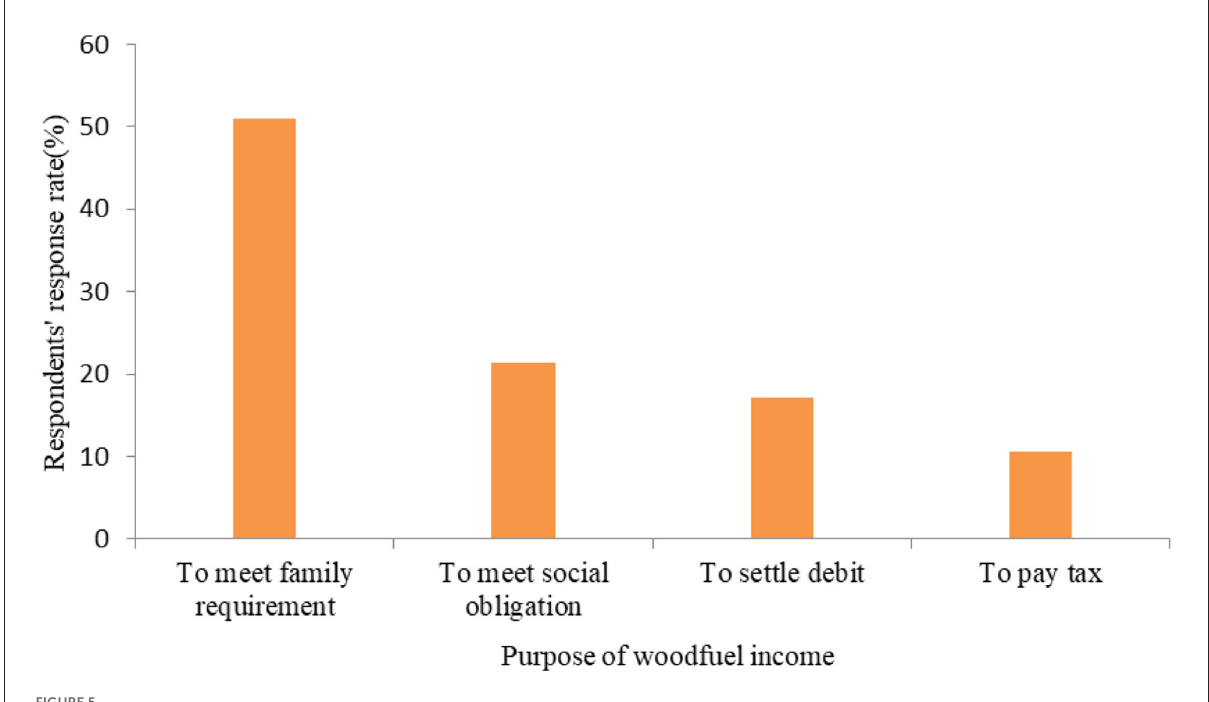
FIGURE5 Purposes of wood fuel income for households.